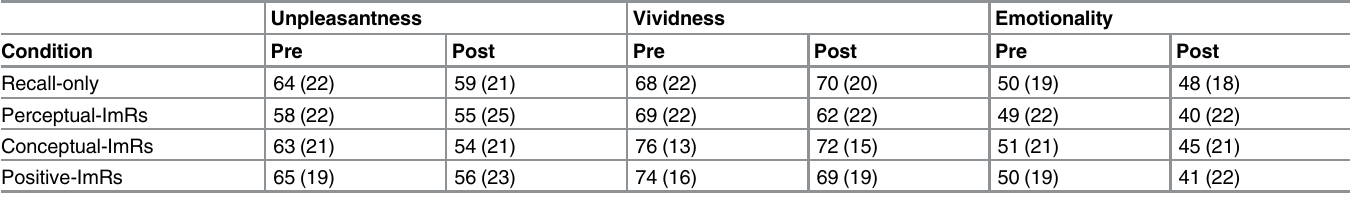
Table 3. Means (SD) of unpleasantness, vividness, and emotionality of the memory at pre- and post-measurement (in mm) per condition.